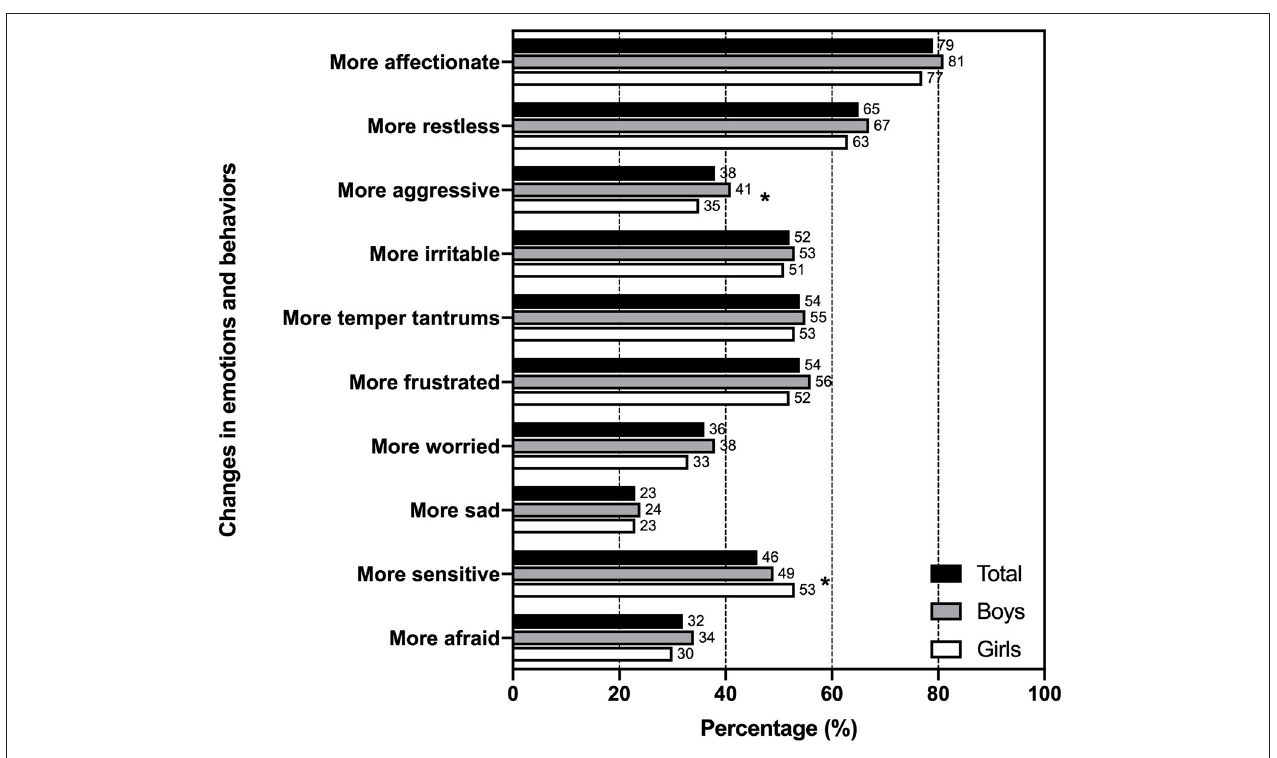
FIGURE 1 | Proportion of children that showed emotional and behavioral changes during early stages of the COVID-19 pandemic in Chile. Emotional changes were measured with a 1 to 5 scale in which 4 or more indicated change. Parents were allowed to answer “not applicable.” *Indicates difference between boys and girls ( p <